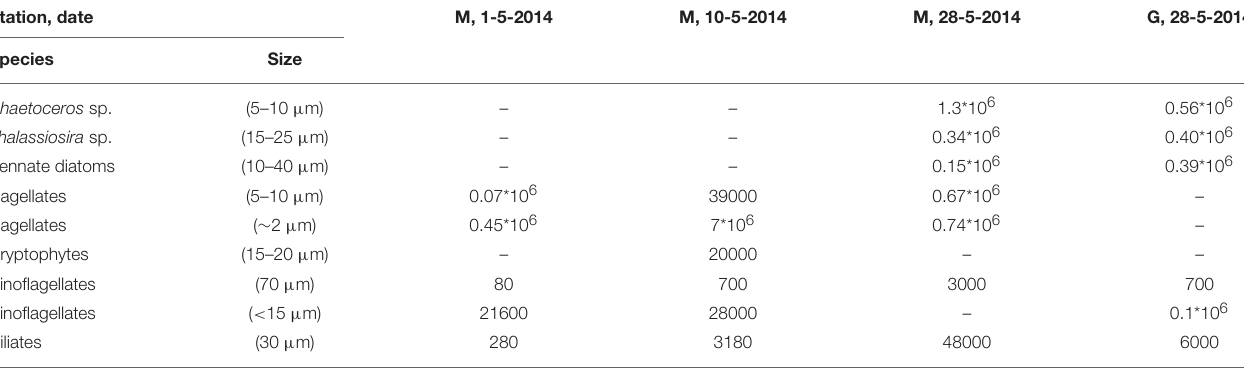
TABLE 3 | Cell counts (cells l − 1 ) of dominant phytoplankton and ciliates of four samples of station M (3) and G (1) in Kongsfjorden obtained by light microscopy.